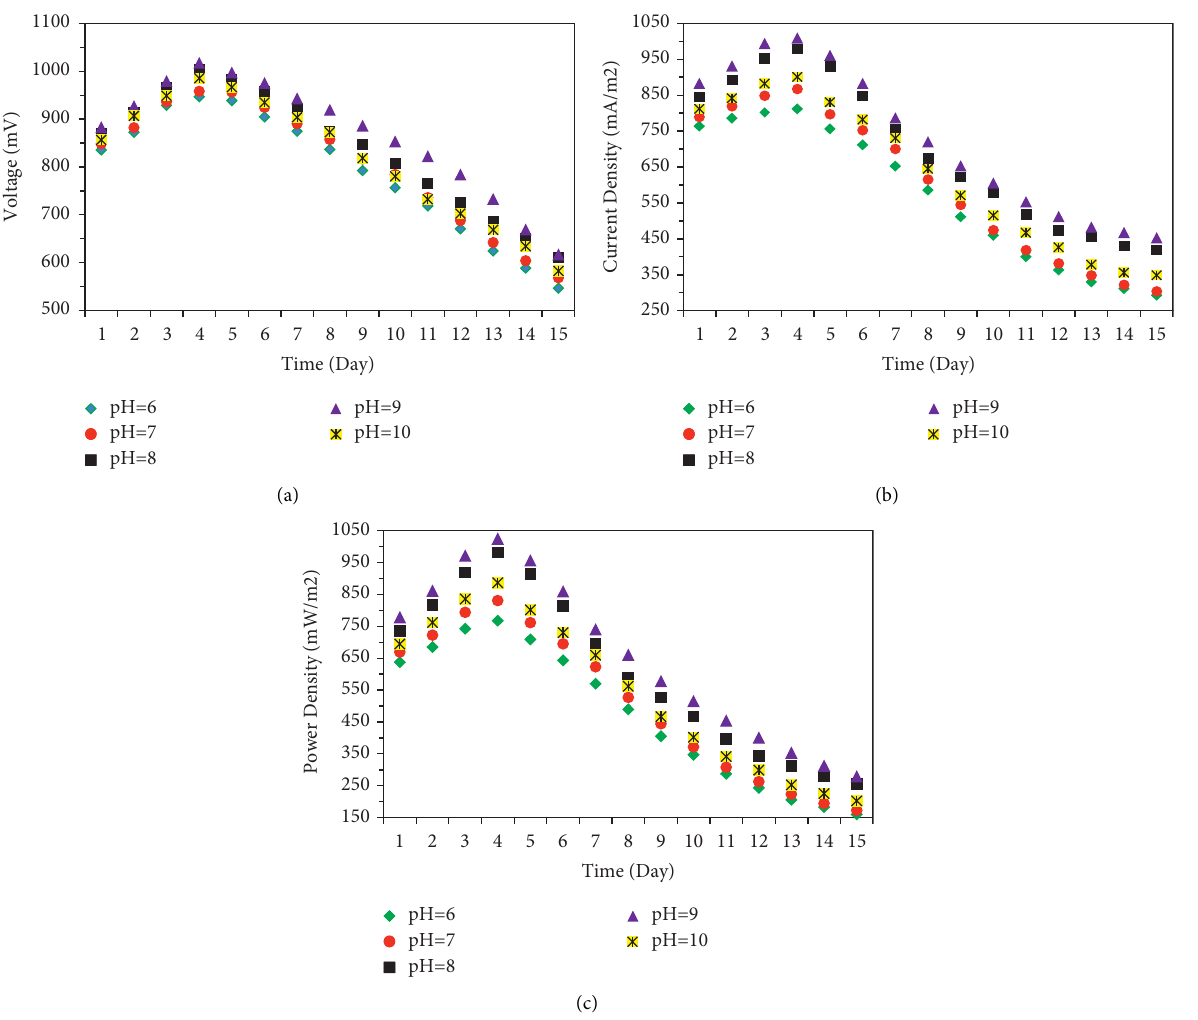
Figure 5: Effect of pH on the (a) generated voltage, (b) current density, and (c) power density by using hospital